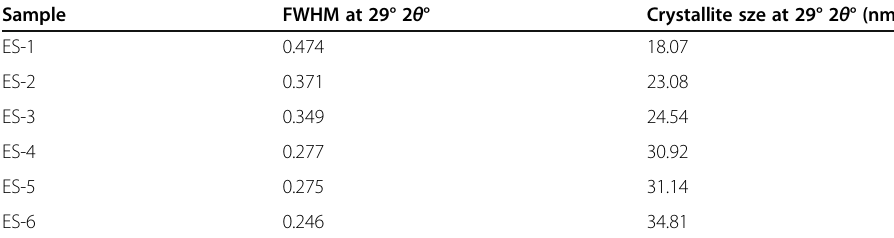
Table 1 Crystallite size of bio-CaCO